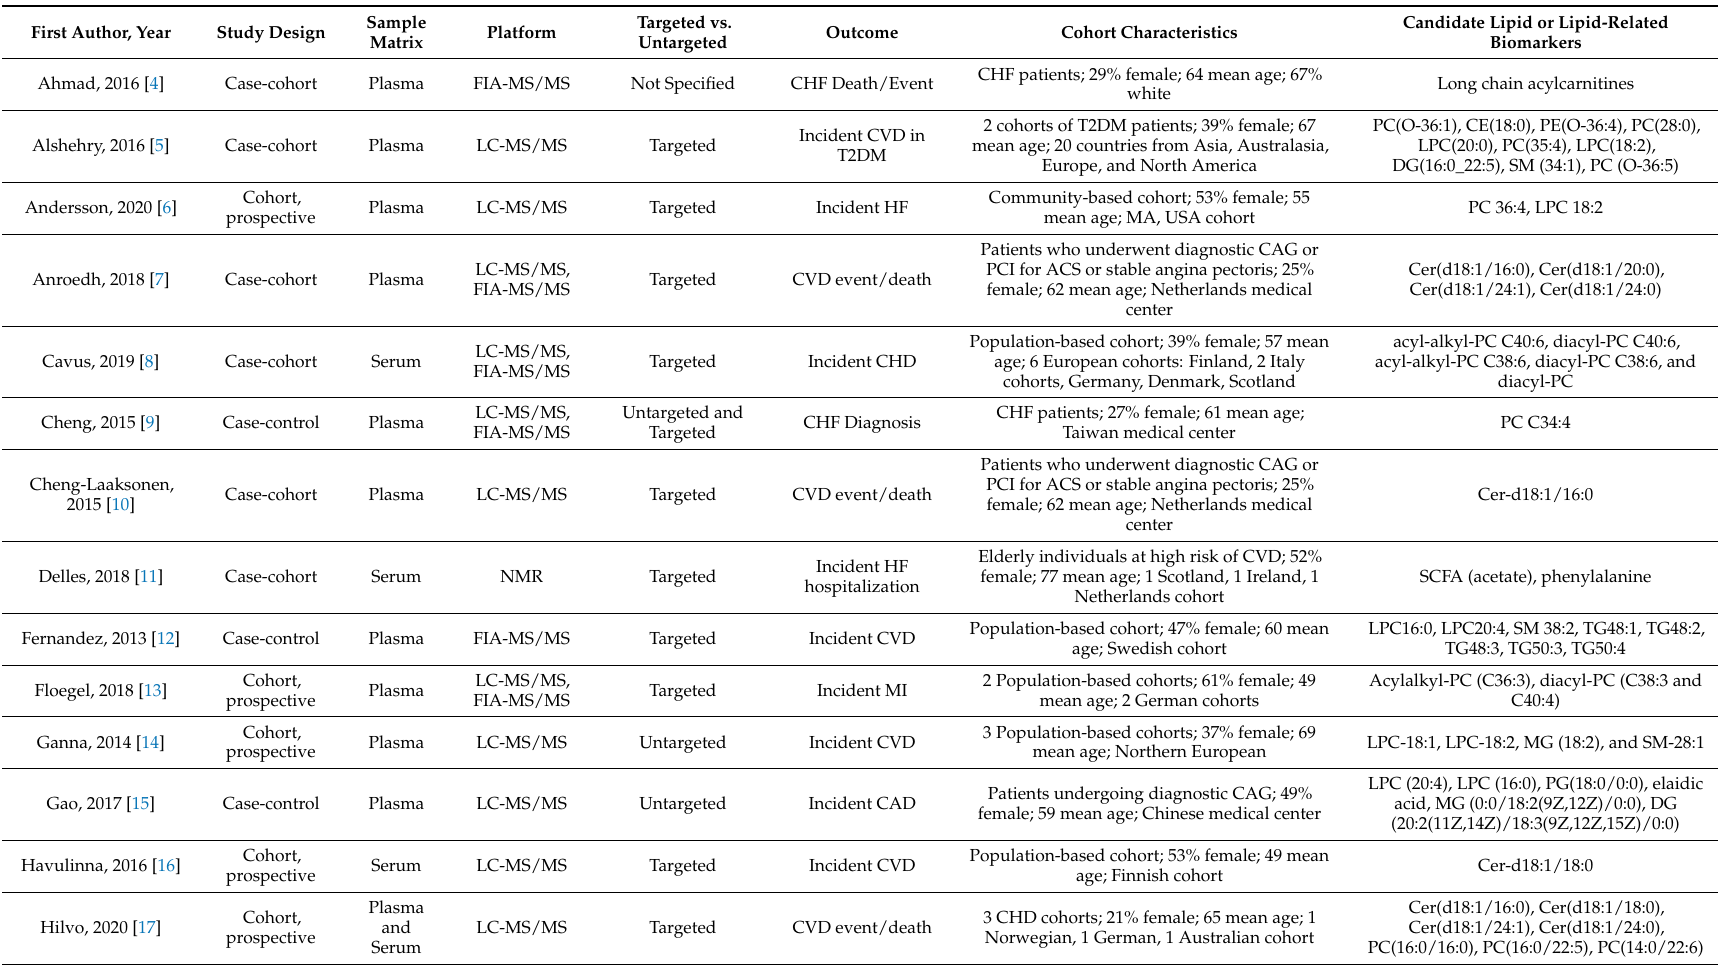
Table 1. Study characteristics of lipidomic studies in cardiovascular